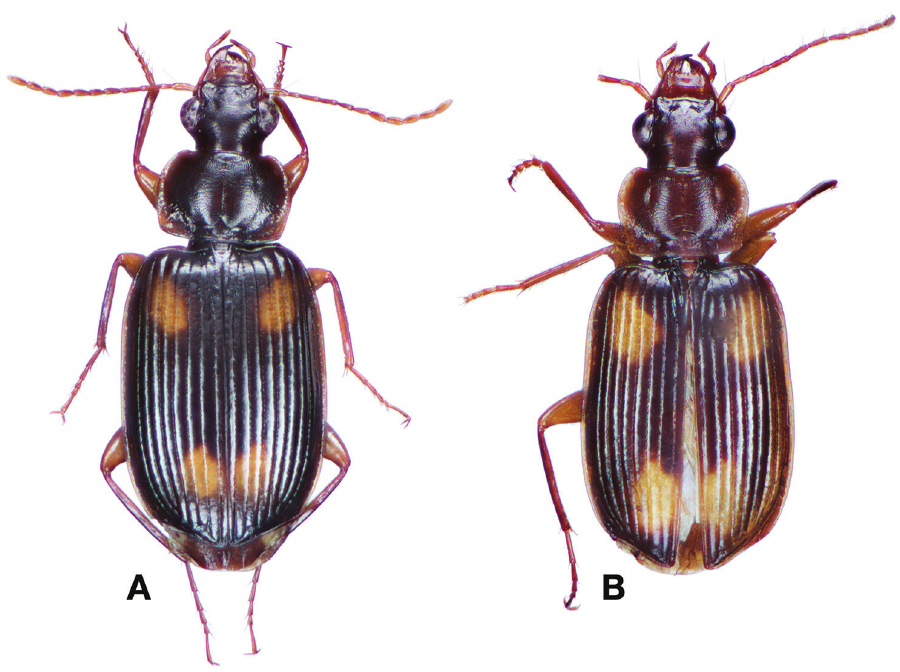
doir A small elytral macula (OBL 7.20 mm) B large elytral macula (OBL 6. 60